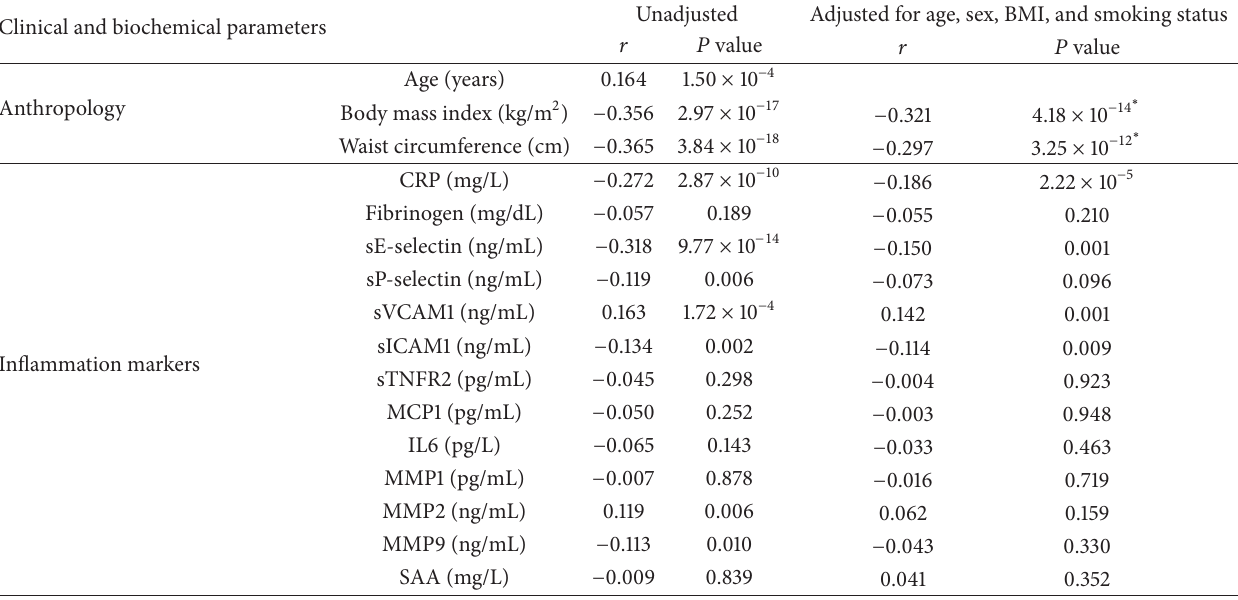
Table 2: Associations between adiponectin levels and adiposity status and inflammatory marker levels in Han Chinese patients in Taiwan. Clinical and biochemical parameters